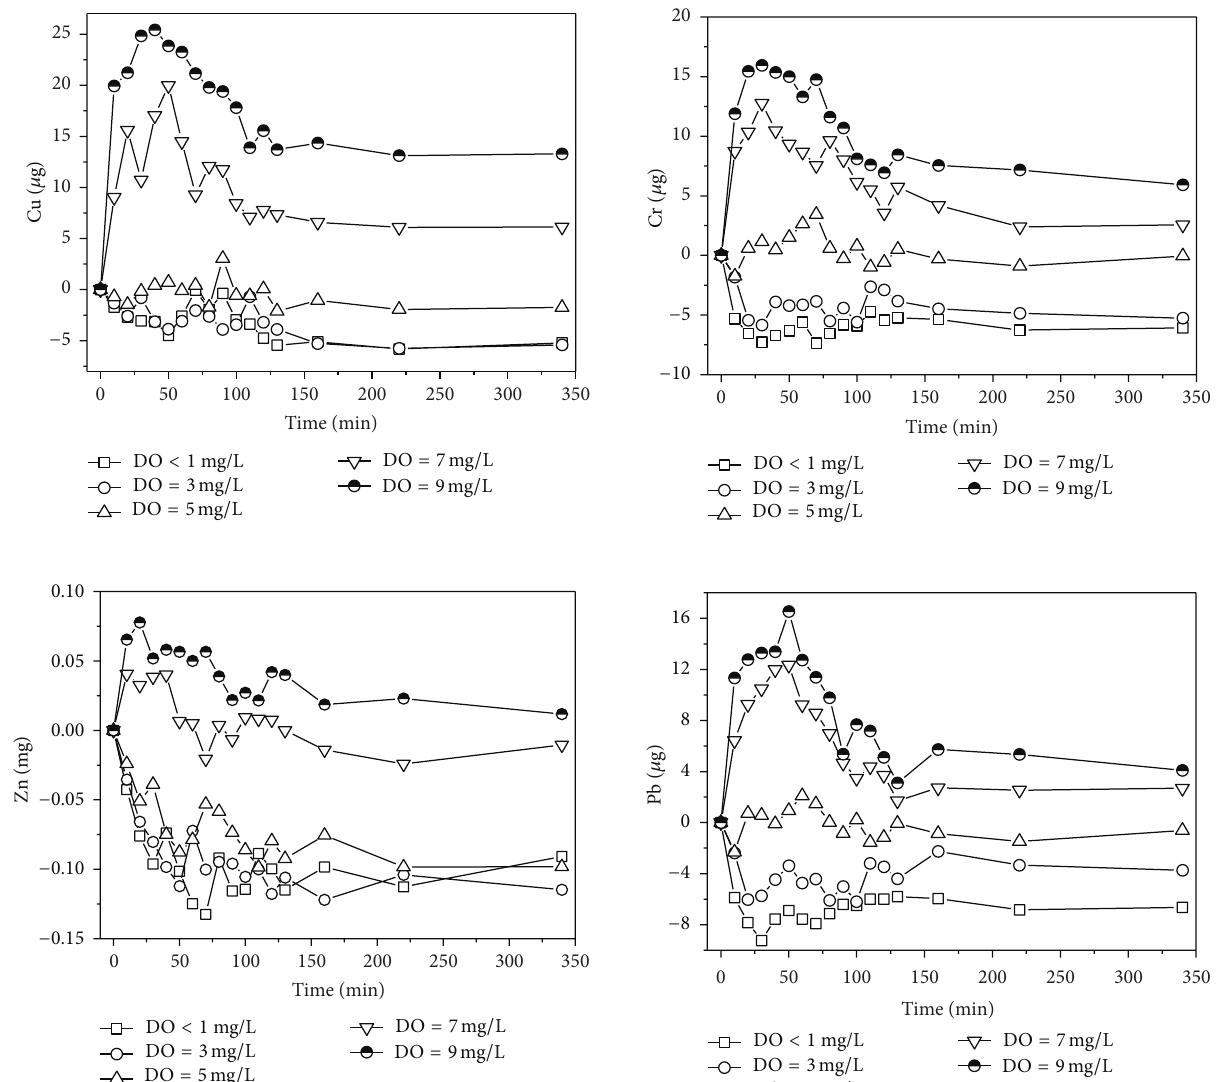
Figure 4: The amount of cumulative release of Cu, Cr, Zn, and Pb from sediments changed with